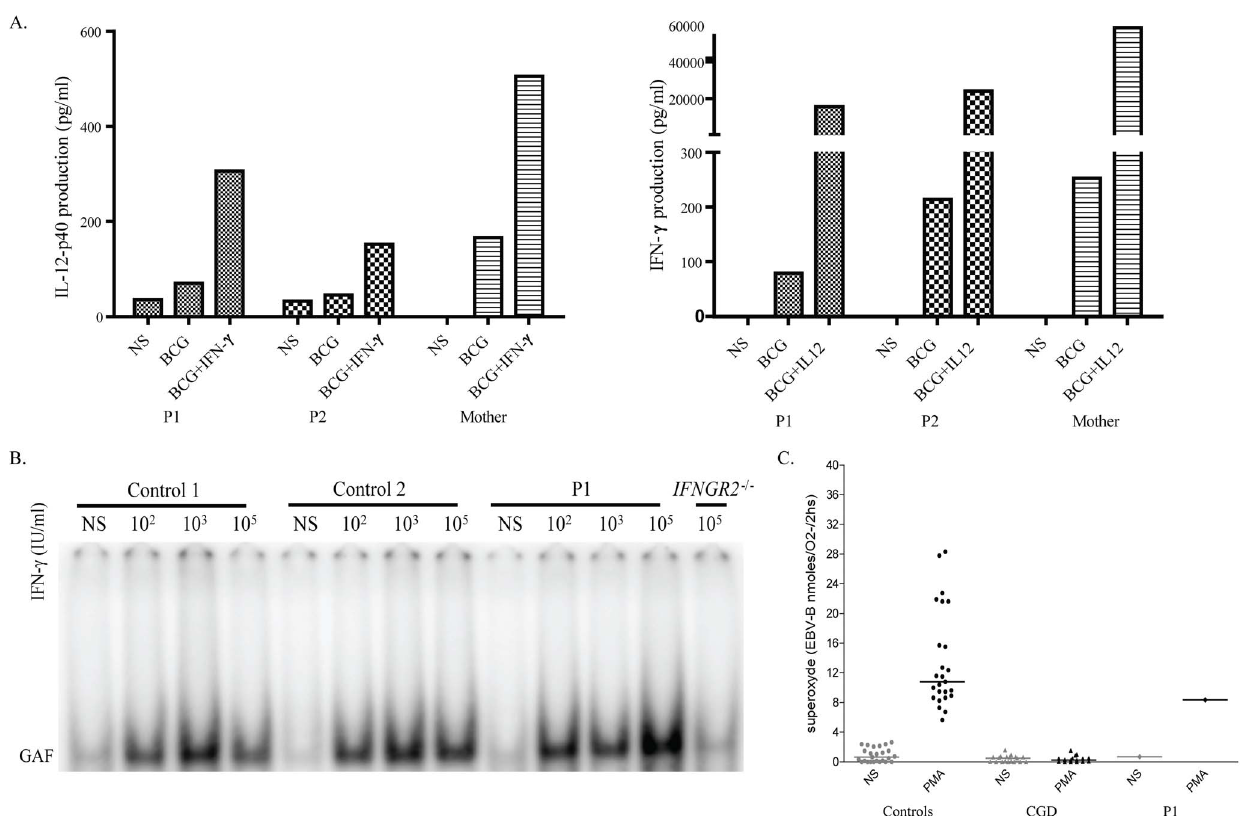
Figure 4. Functional study of the IFN- c /IL-12 axis and oxidative burst in P1. A). Whole-blood IL-12/IFN- c pathway screening. P1 and P2 had normal responses to IFN- c and IL-12. B). EMSA detecting GAF DNA-binding activity after IFN- c stimulation in the EBV-B cells from two healthy controls, P1 and individuals with complete recessive IFN- c R2 deficiency, used as a negative control. Cells were stimulated for 15 minutes with the indicated dose of IFN- c . C). Oxidative burst. The production of superoxide in the EBV-B cells from healthy controls, P1 and patients with chronic granulomatous disease, used as negative controls, was determined following stimulation with PMA. These experiments were carried out at least